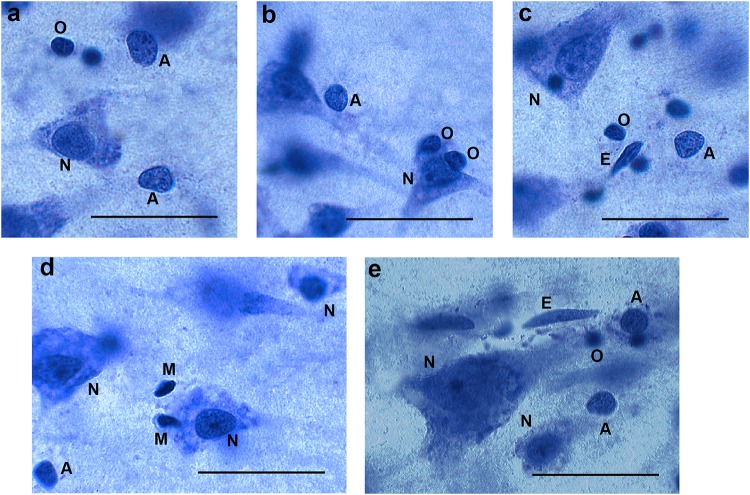
Different cell types in 40 μm thick sections (not all cells are in focus). Panels (a−c) from AIDS brains, panels (d,e) from control subjects. N = neurons, A = astroglia, O = oligodendroglia, M = microglia. E = endothelial cell (not counted). Bar = 30μm.